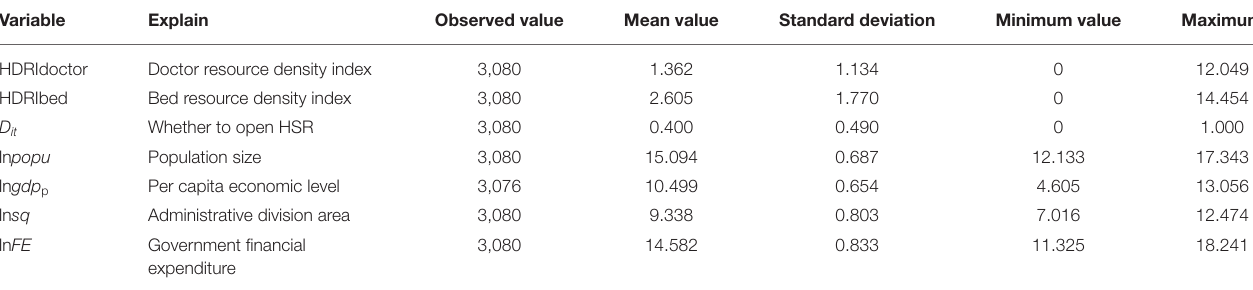
TABLE 1 | Descriptive statistics of main